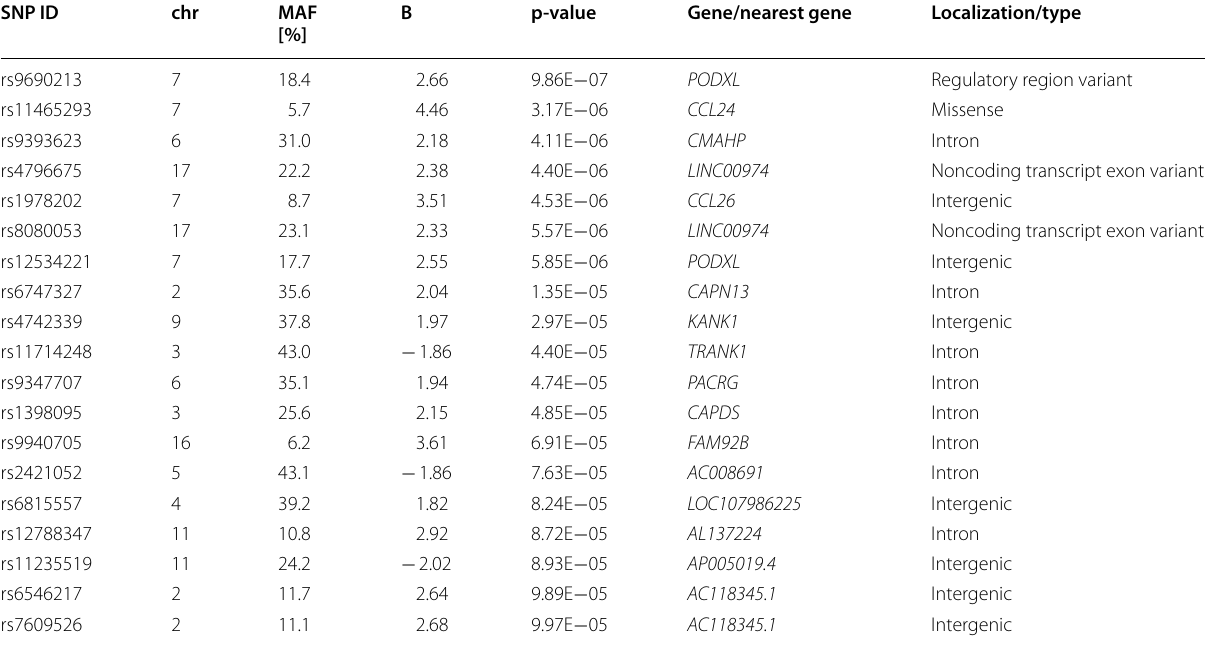
Table 3 The list of variants localized to genes associated with BMI in T2D-GENES and ARIC cohorts which associate with